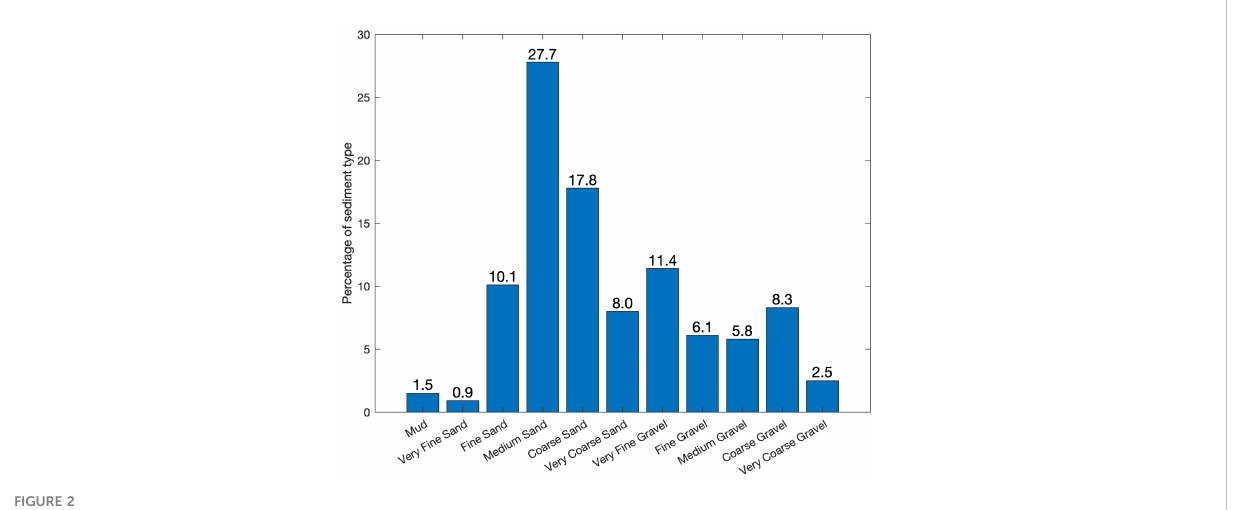
Figure 9 indicated the correlation between the sediment properties and environmental variable. R 2 and p-values were calculated for each sediment properties and environmental variable. As can be seen, the trends and relationship were shown on the graph, and all the correlation and relationship were presented on Figure 12.